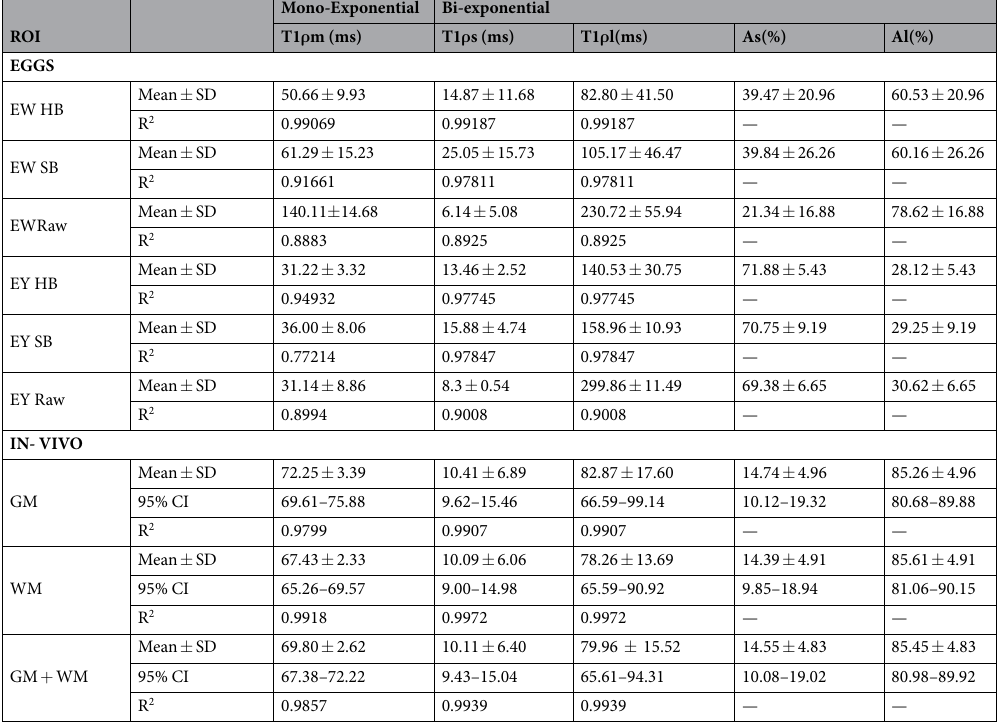
Table 1. Egg experiments fitting results (N = 2) and volunteer human brain fitting results (N = 7). EW- eggwhite, EY- eggyolk, HB-hard-boiled, SB-soft-boiled, GM-Gray Matter, WM-white matter, GM + WM- gray and white